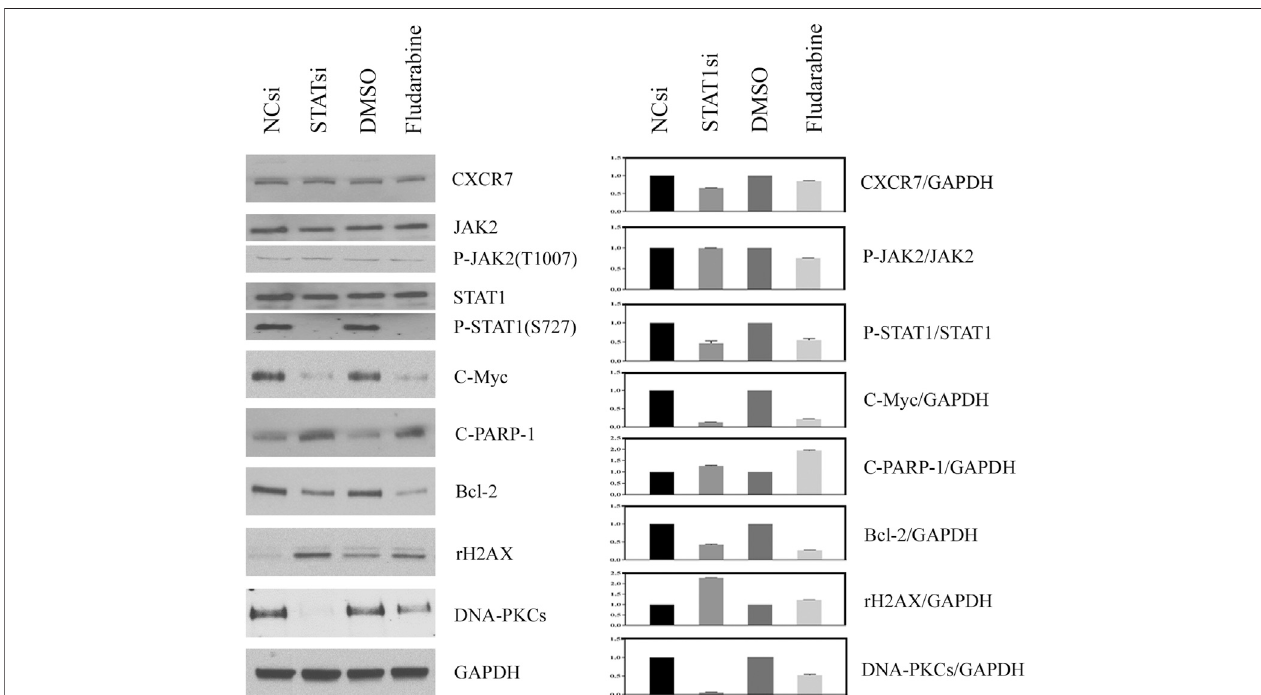
FIGURE 3 | Change pro fi le of downstream functional proteins after the inhibition of STAT1 activity. (A) Western blotting revealed that, after knocking down the expressionofJAK2bysiRNAtransfectionandrepressingtheactivityofJAK2byFLUDinC4-2Bcells,theexpressionofCXCR7andP-JAK2didnotdisplayanychange, but the expression of C-Myc and Bcl-2 decreased remarkably. In contrast, the expression of DNA damage marker γ H2AX increased apparently, the expression of homologous repairing (HR) protein C-PARP-1 increased accordingly, but the expression of non-homologous end-joining (NHEJ) repairing protein DNA-PKCs decreased measurably. (B) All WB band densities were quantitative